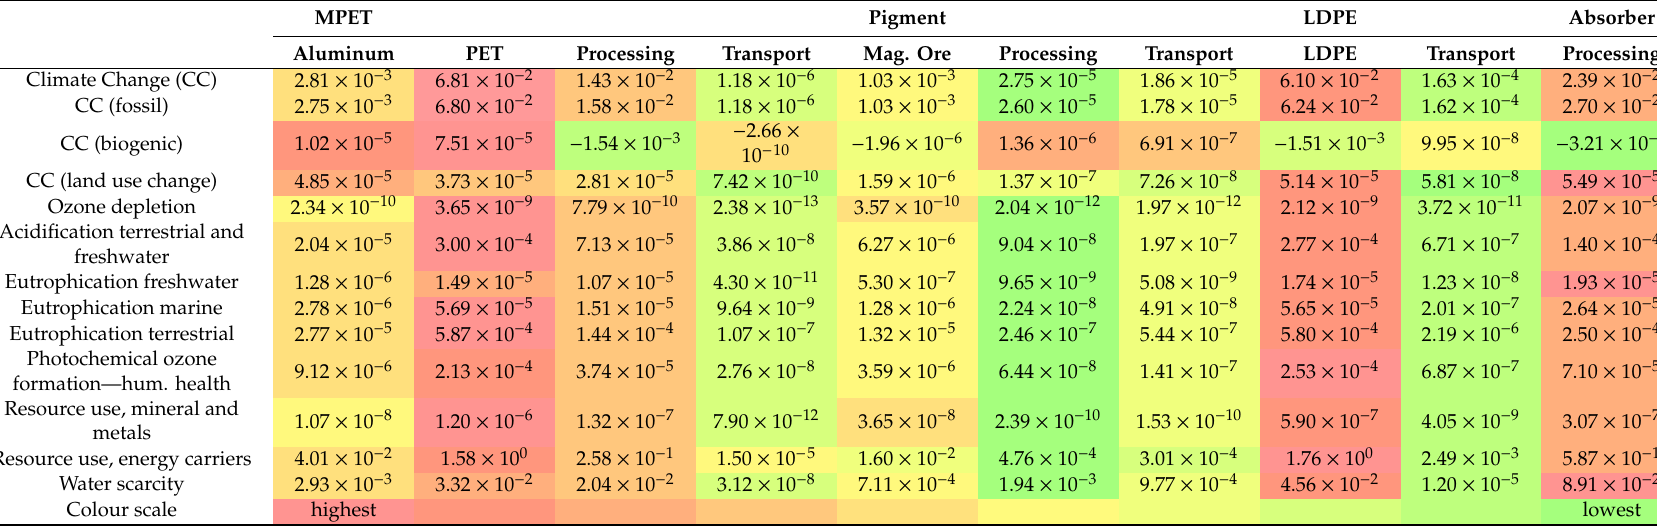
Table 3. Environmental impacts of the production of the P1 absorber (per 1 m 2 ) divided by individual materials and processes shown in Figure 2. The gradual color scale indicates the influence of individual materials and processes on the results in particular impact